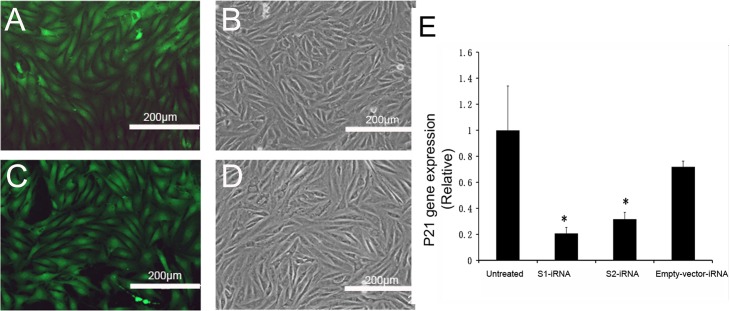
Effects of RNAi on the p21 expression in the ASCs.GFP expression was monitored under a fluorescent microscope 48h after lentiviral infection. A and B, the p21-shRNA-infected ASCs. C and D, the empty-vector-infected ASCs. Fluorescence was clearly observable in both the p21-shRNA-infected ASCs (3A) and the empty-vector-infected ASCs (3C). Cells from both groups were healthy. E: RT-qPCR of the p21 expression. Note that both of the target sequences (S1 and S2) significantly down-regulated p21 mRNA expression in the ASCs (P<0.05). No significant difference was found between the empty-vector-iRNA ASCs and the untreated ASCs (P>0.05).